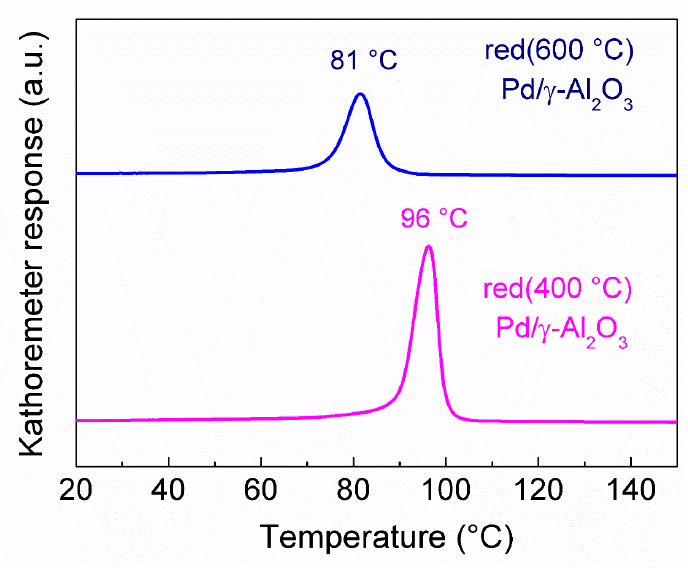
Figure 5. Temperature-programmed hydride decomposition for red(400 °C)-Pd/ γ -Al 2 O 3 and C-red(600 °C)-Pd/ γ -Al 2 O 3 .